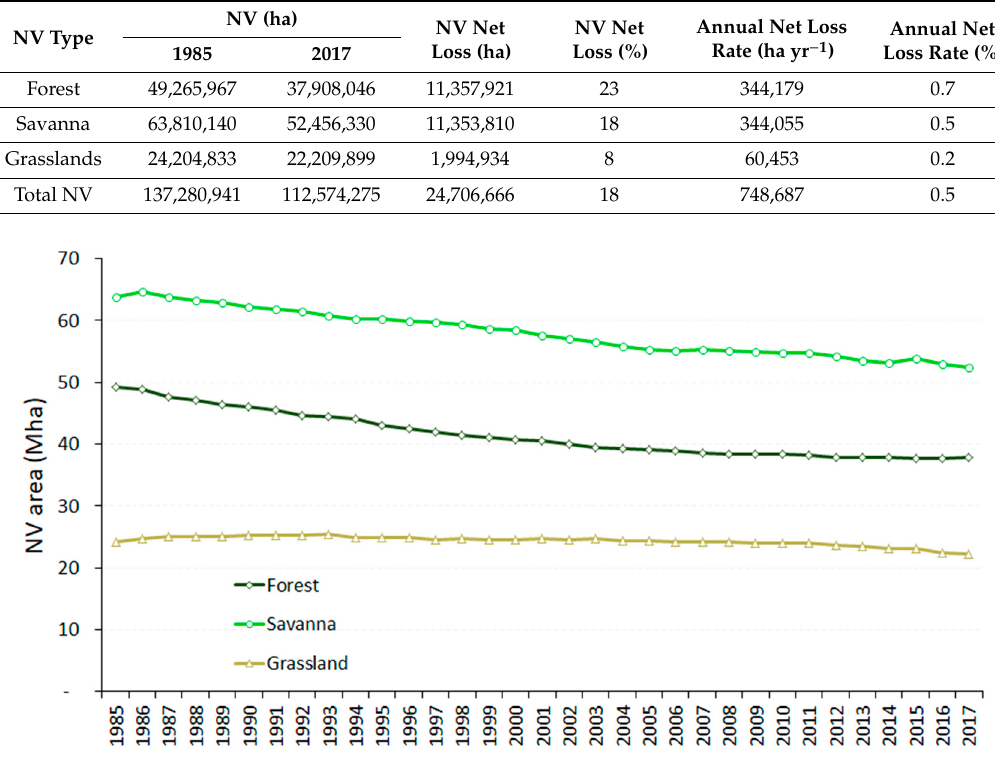
Figure 4. Area (hectare) occupied by the three native vegetation types (forest in dark green, savanna in light green, and grassland in beige) in the Brazilian Cerrado over the time period of 1985–2017. Mha = million hectares; NV = native Cerrado vegetation.